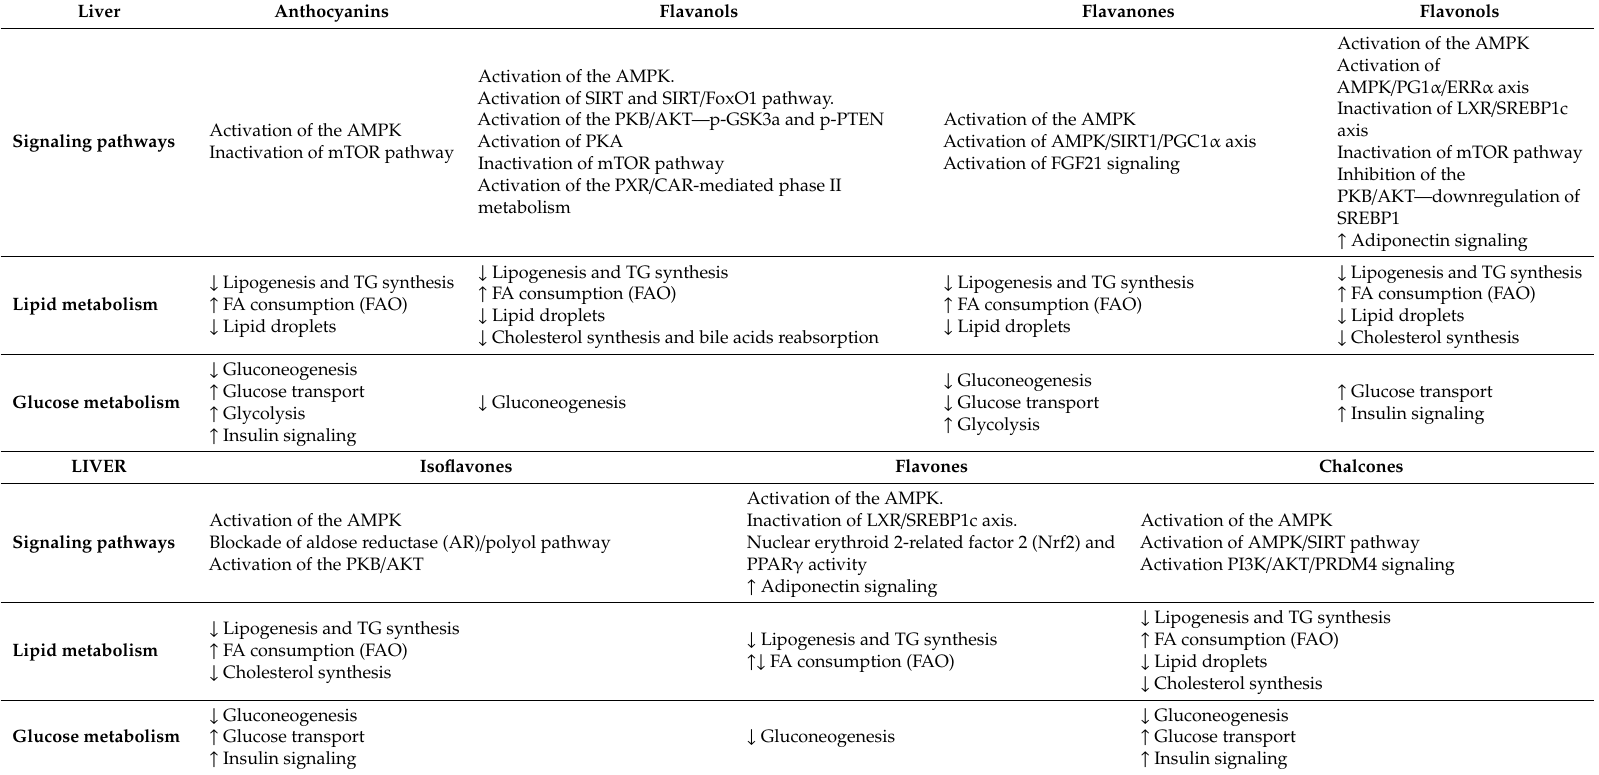
Table 2. Metabolic e ff ects and signaling pathways underlying the anti-obesity e ff ects of flavonoids in the